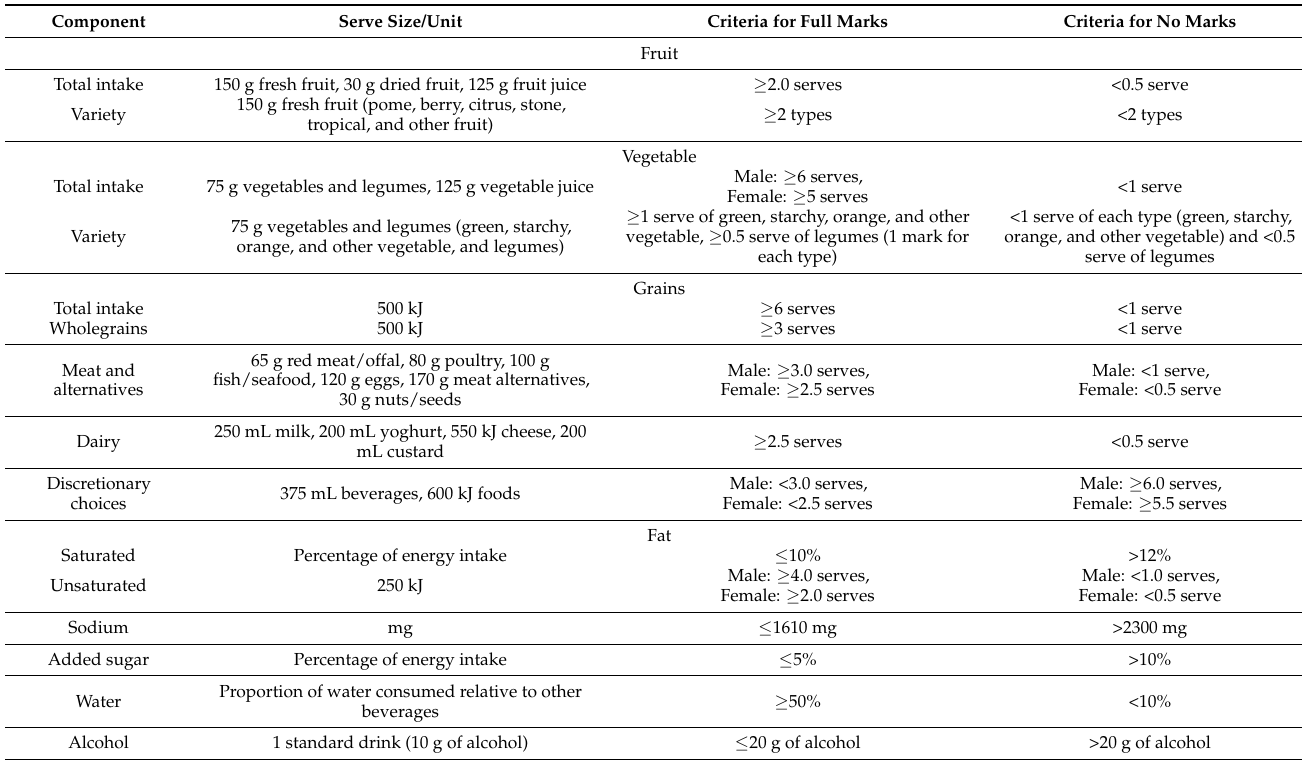
Table 1. Serve sizes and criteria for full and no marks of each component in the Healthy Eating Index for Australian Adults